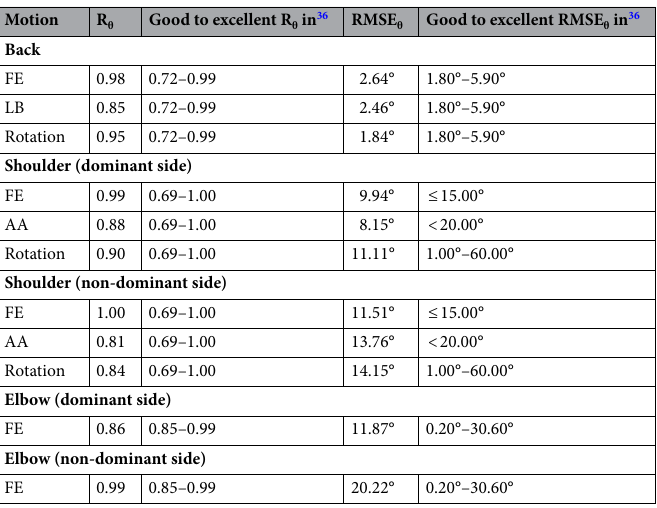
Table 5. The average R and RMSE of the back, shoulder and elbow joint angles (R θ , RMSE θ ) and the good to excellent R